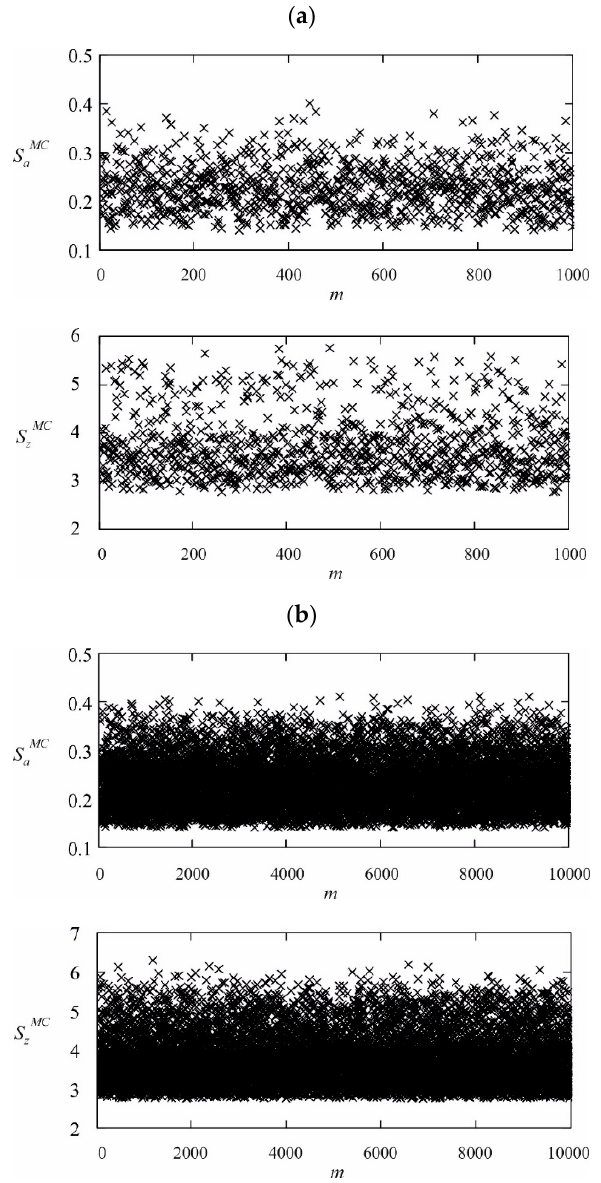
Figure 2. ( a ) Values of factors Sa MC and Sz MC for the Monte Carlo trials equal to 10 3 . ( b ) Values of factors Sa MC and Sz MC for the Monte Carlo trials equal to 10 4 .